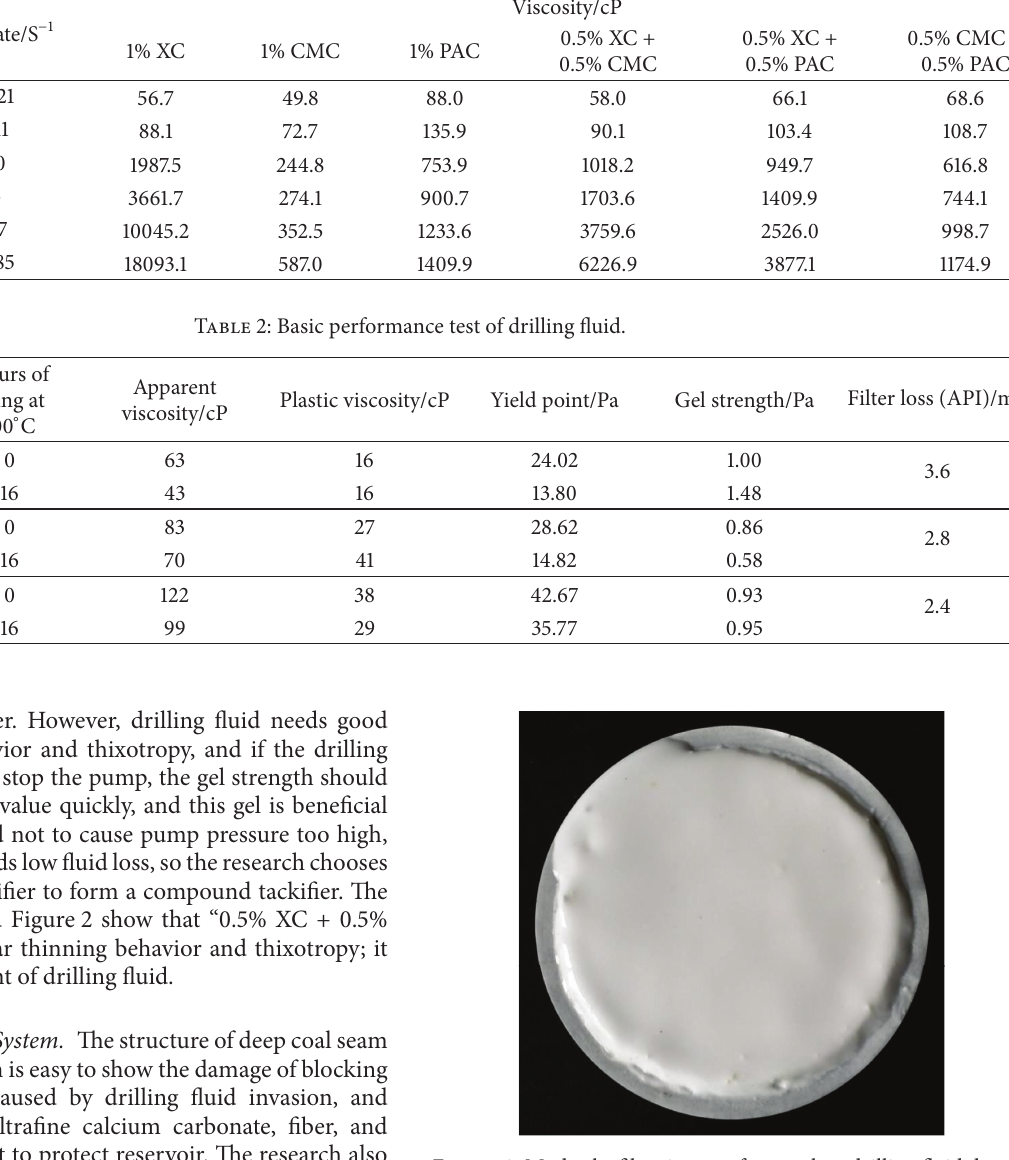
Figure 3: Mud cake filtration test forms when drilling fluid density is 0.93 g ⋅ cm −3